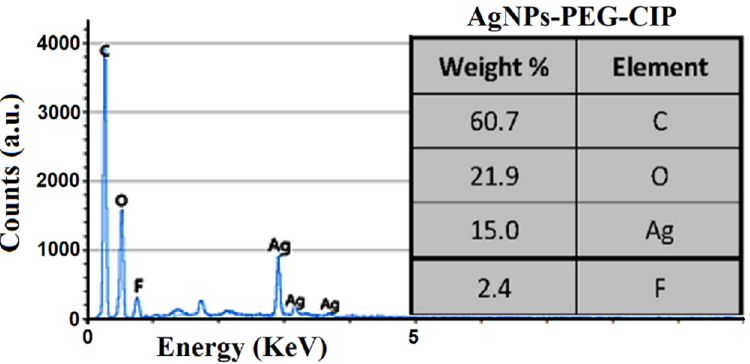
Figure 10. EDX spectra for AgNPs, AgNPs-PEG, and AgNPs-PEG-CIP.